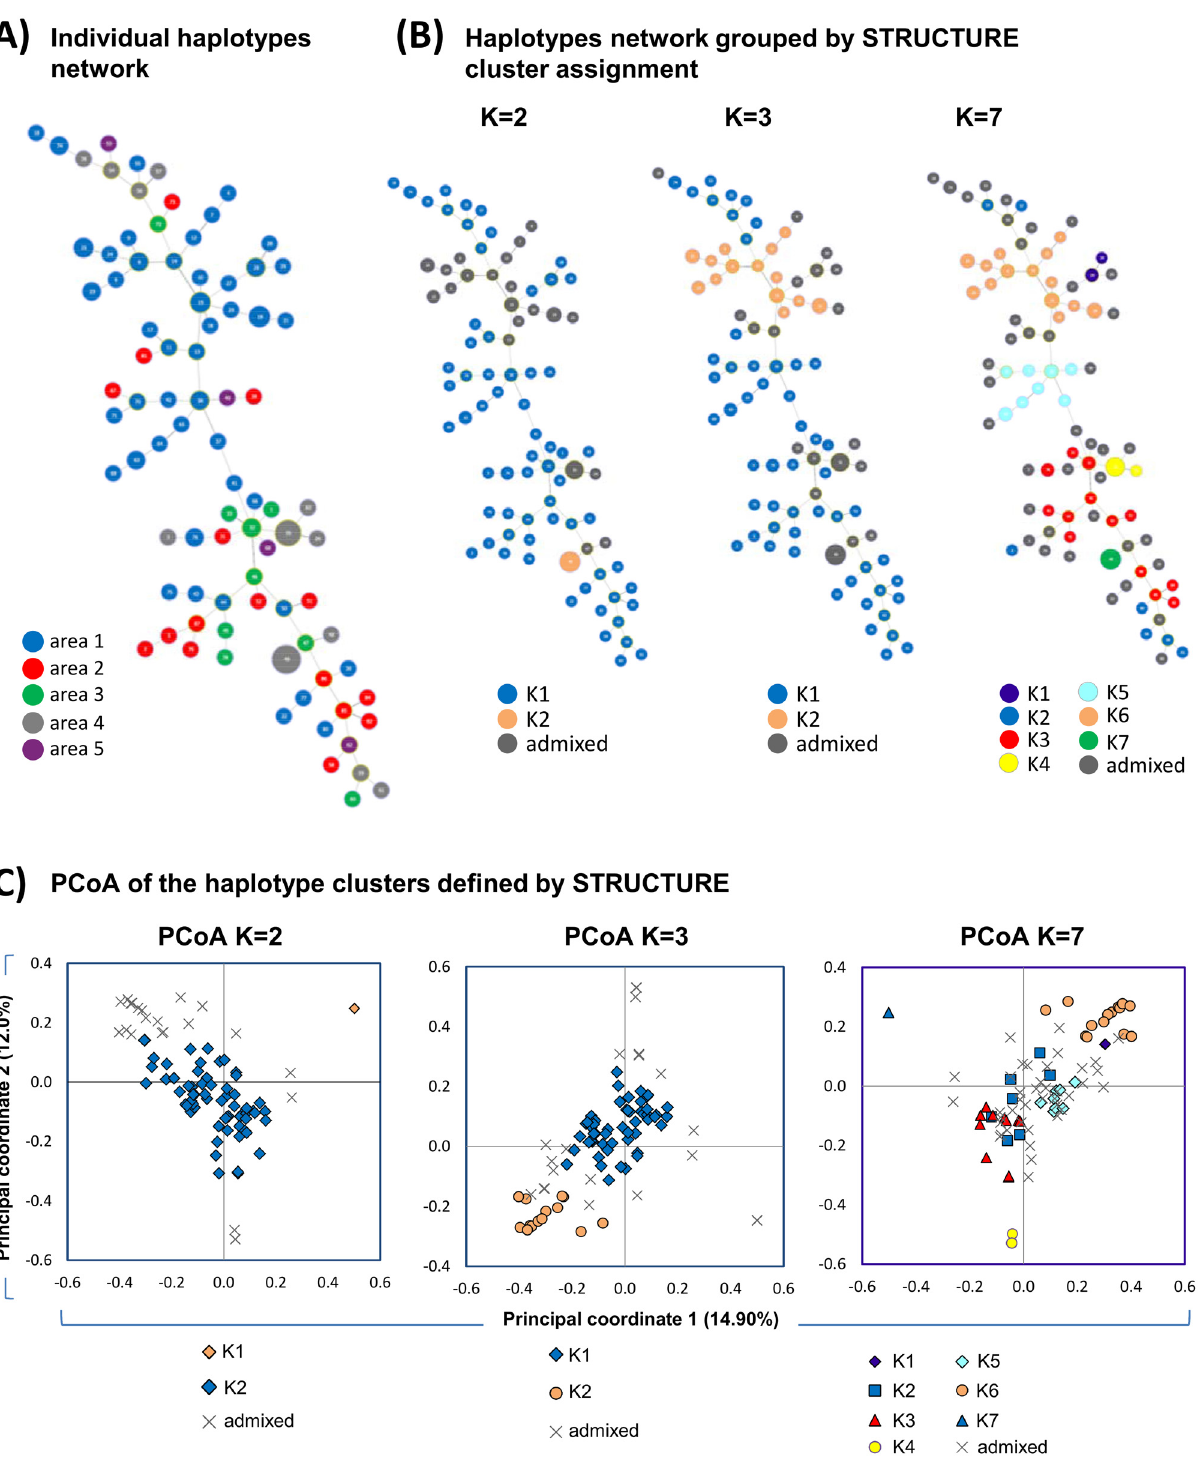
Fig 5. Phylogenetic relationship and PCoA of the P . vivax haplotypes arranged by the geographic origin and the genetic clustering. (A) Network analysis displaying the phylogenetic relationship of the P . vivax haplotypes. The haplotypes are coloured following the area colour code displayed in the legend. The size of the nodes denotes the number of haplotypes transformed in logarithmic scale. (B) Phylogenetic relationships and PCoA of the isolates assigned into 2, 3 and 7 genetic clusters following STRUCTURE criteria. The nodes were coloured to discriminate their assignment to a genetic cluster ( K 1, K 2 ... ) or as an admixed haplotype and the node ’ s size varied as described previously. When K = 3 only 2 clusters are described ( K 1 and K 2) since no